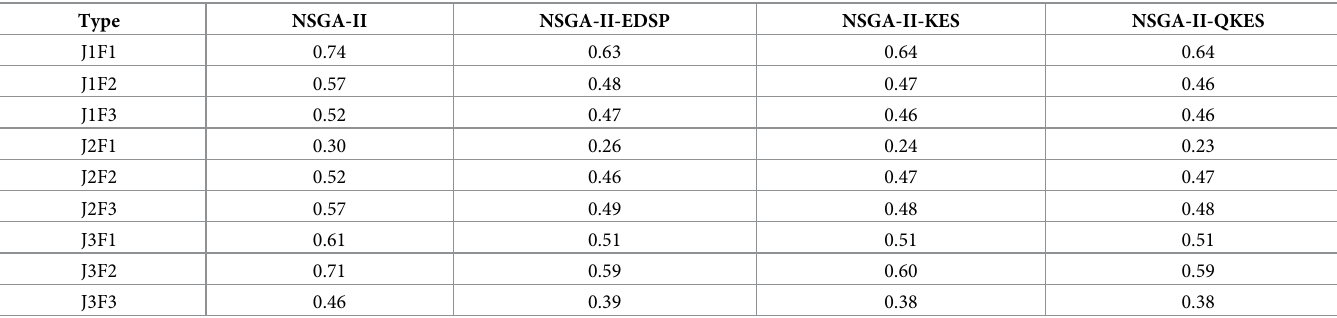
Table 8. Comparison of error ratio of each